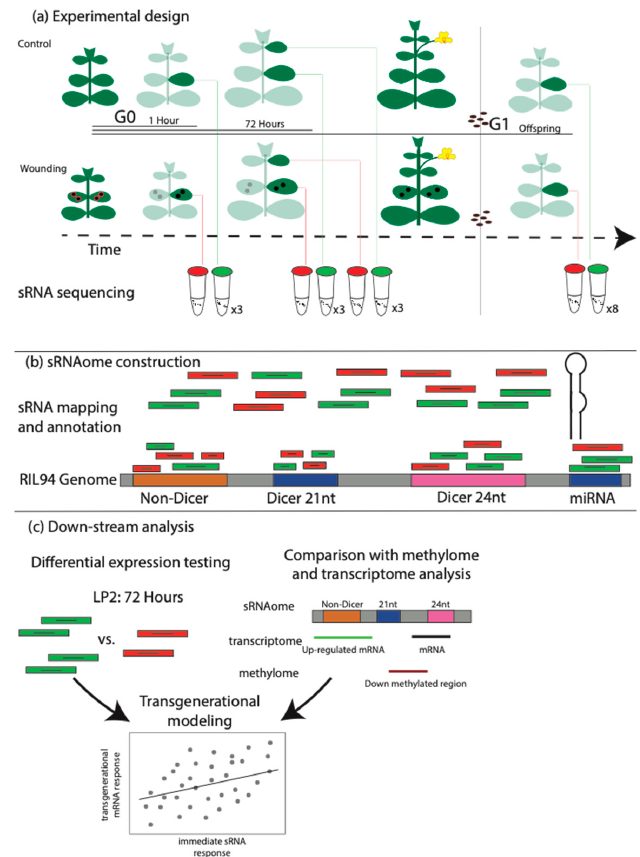
Figure 1. Experimental design and analytical methods. ( a ) Plants were germinated and placed into